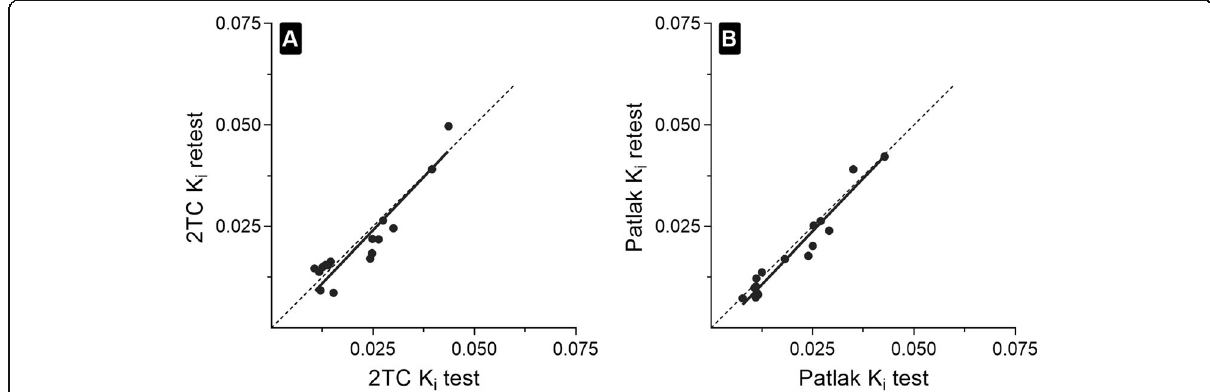
Fig. 6 Reproducibility of parametric images shown as a correlation of a test-retest 2TC K i values ( R 2 = 0.85, p < 0.0001) and b test-retest Patlak K i values ( R 2 = 0.94, p < 0.0001) for the metastatic lesions in a group of patients rescanned after 1 week ( n = 5). The solid line is the Deming line, and the dotted line is the identity